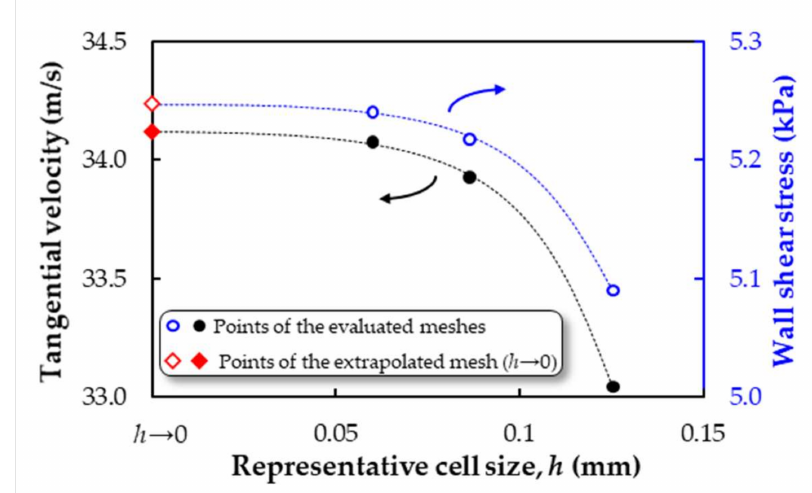
Figure 7. Qualitative representation of the grid convergence study.